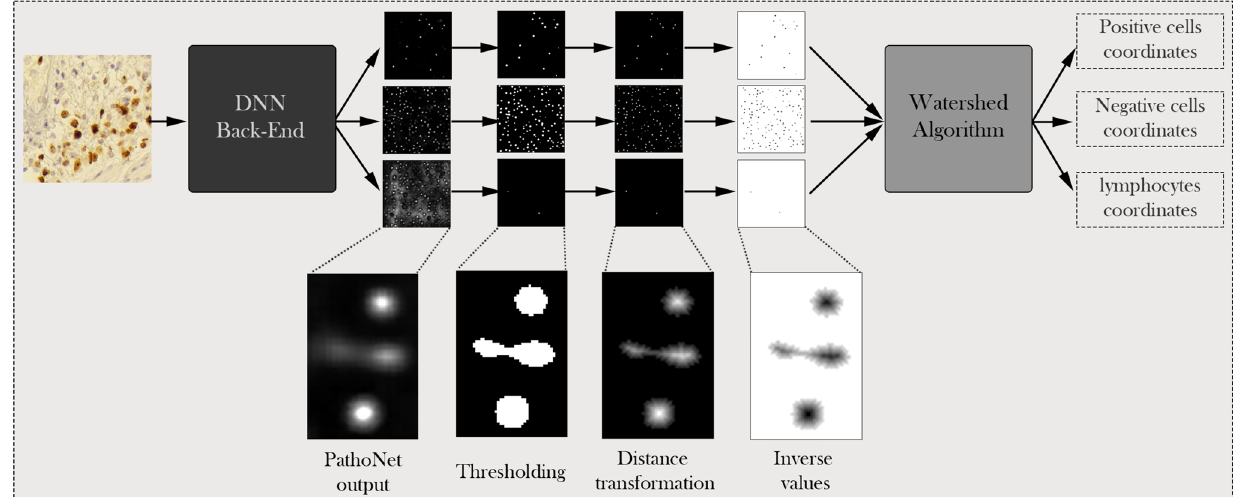
Figure 7. The proposed pipeline. First, a backend, which is a density map estimator based on CNNs, predicts a density map for each class. Then thresholding applies to density maps and produces binary images. Further, inversed distance transformation scores region centers with low and borders with high values. Finally, the watershed algorithm predicts cell centers, and the pipeline outputs the cell